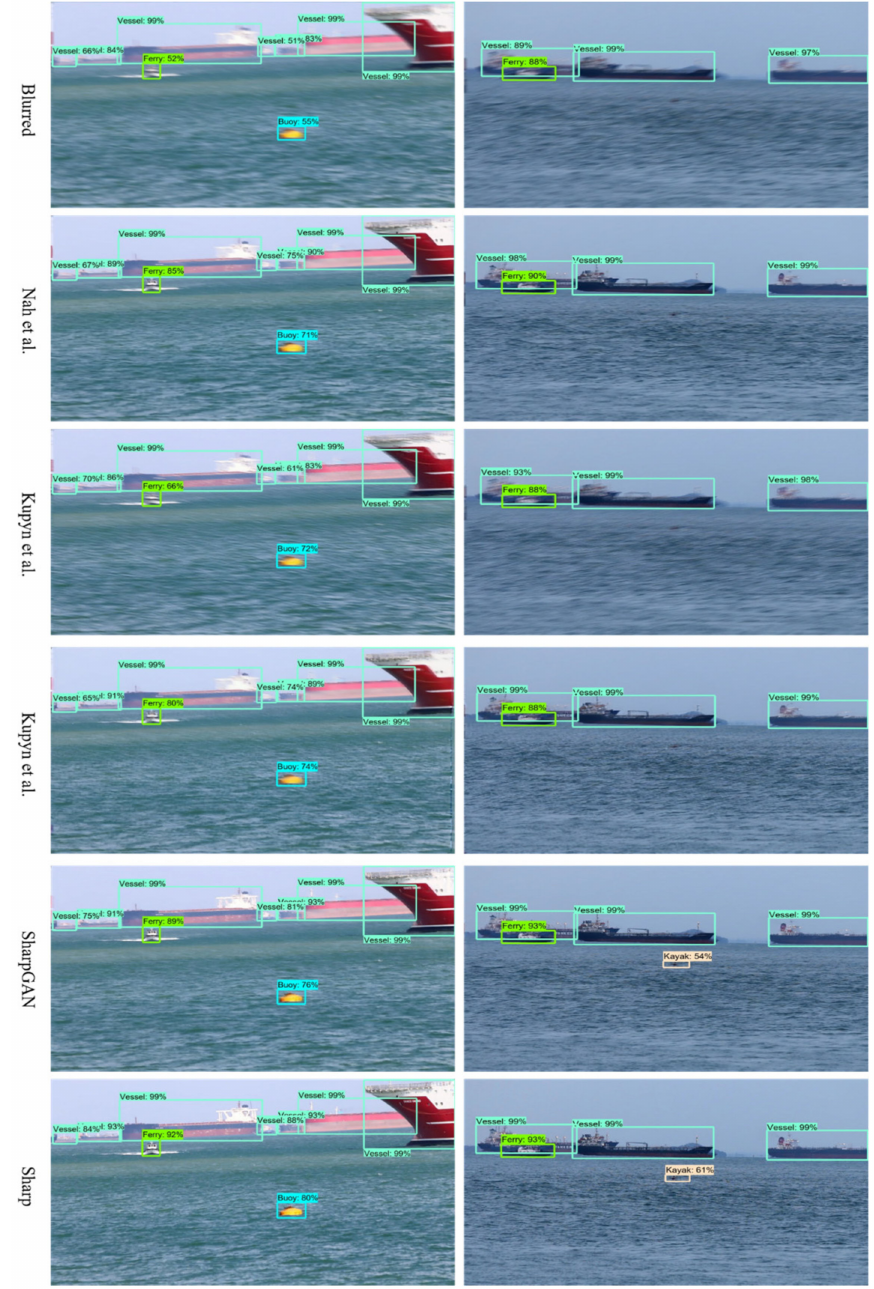
Figure 6. The object detection results of the SMD dataset [32]. From top to bottom: results of blurred images, Nah et al. [12], Kupyn et al. [14], Kupyn et al. [23], SharpGAN, and the results of sharp